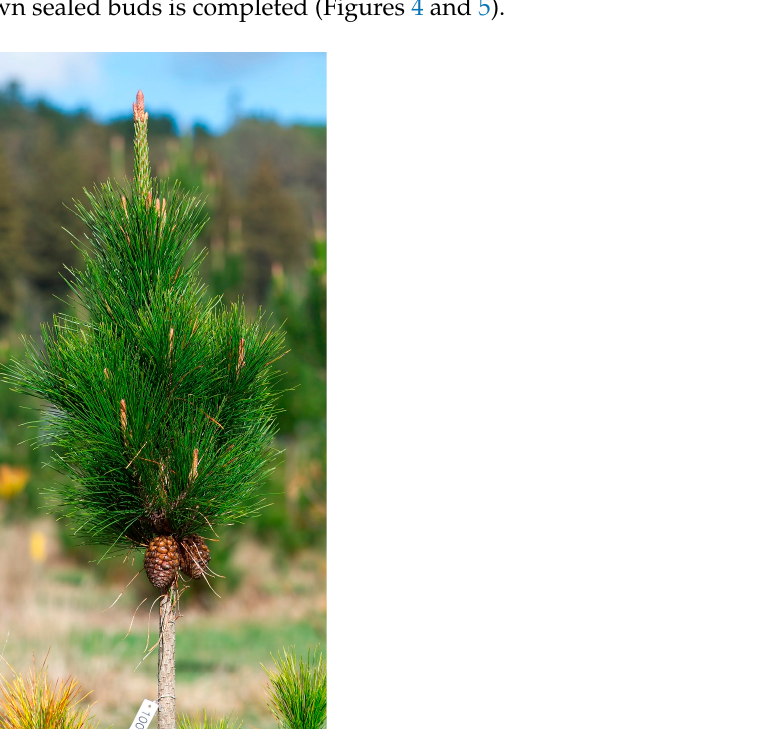
Figure 4. Graft of P. radiata , showing adult shoot morphology of the tree from which scion was taken, with entirely secondary foliage, sealed buds, and seed cones. Shoot growth has become quite strongly seasonal, but the top shows features of a “basal flush” (Scion Image Library).